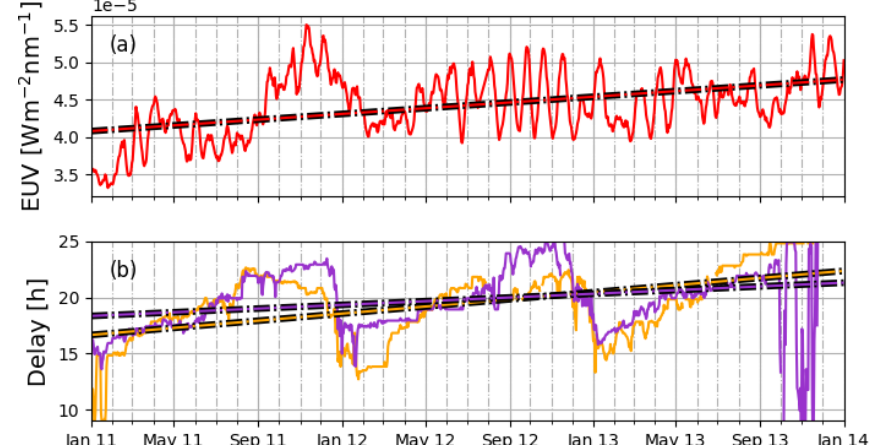
Figure 11. Plot (a) shows the integrated EUV fluxes from 6 to 105nm and the linear trend of the EUV (dash-dotted line). Plot (b) shows the delays of TEC against EUV for Rome (orange) and Canberra (purple), as well as the linear trends of the delays (dash-dotted